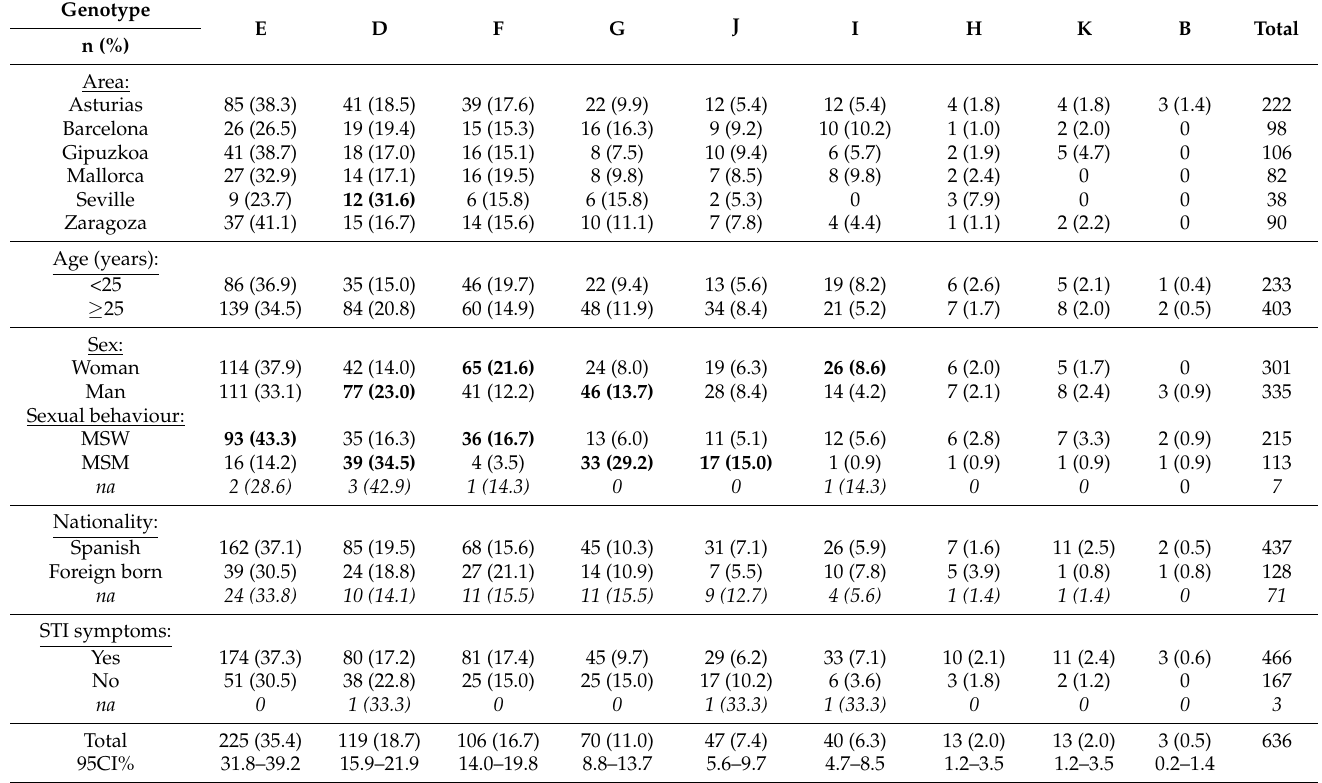
Table 2. Distribution of ompA genotypes in 636 cases of C. trachomatis infection in Spain